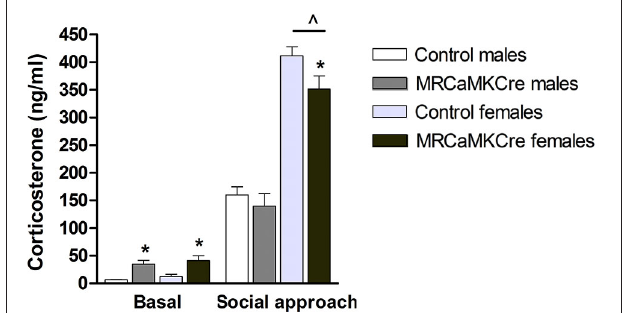
FIGURE 5 | Plasma corticosterone concentrations of male and female MR CaMKCre and control mice . Measured before and after the social approach paradigm. White bars represent control males ( n = 9) and light grey bars represent the female control mice ( n = 15). Dark grey represent the male MR CaMKCre mice ( n = 8) and black bars the female MR CaMKCre mice. * p < 0.05 compared to controls same treatment; ^ p < 0.05 compared to males. All data are expressed as mean ± S.E.M.